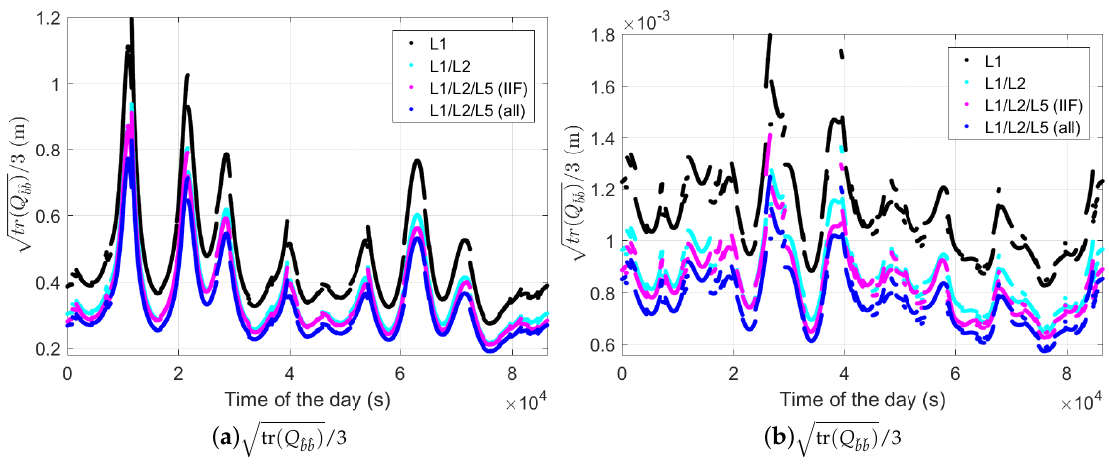
(cid:113) ) /3 ( a ) and Figure 3. tr ( Q ˆ b ˆ b